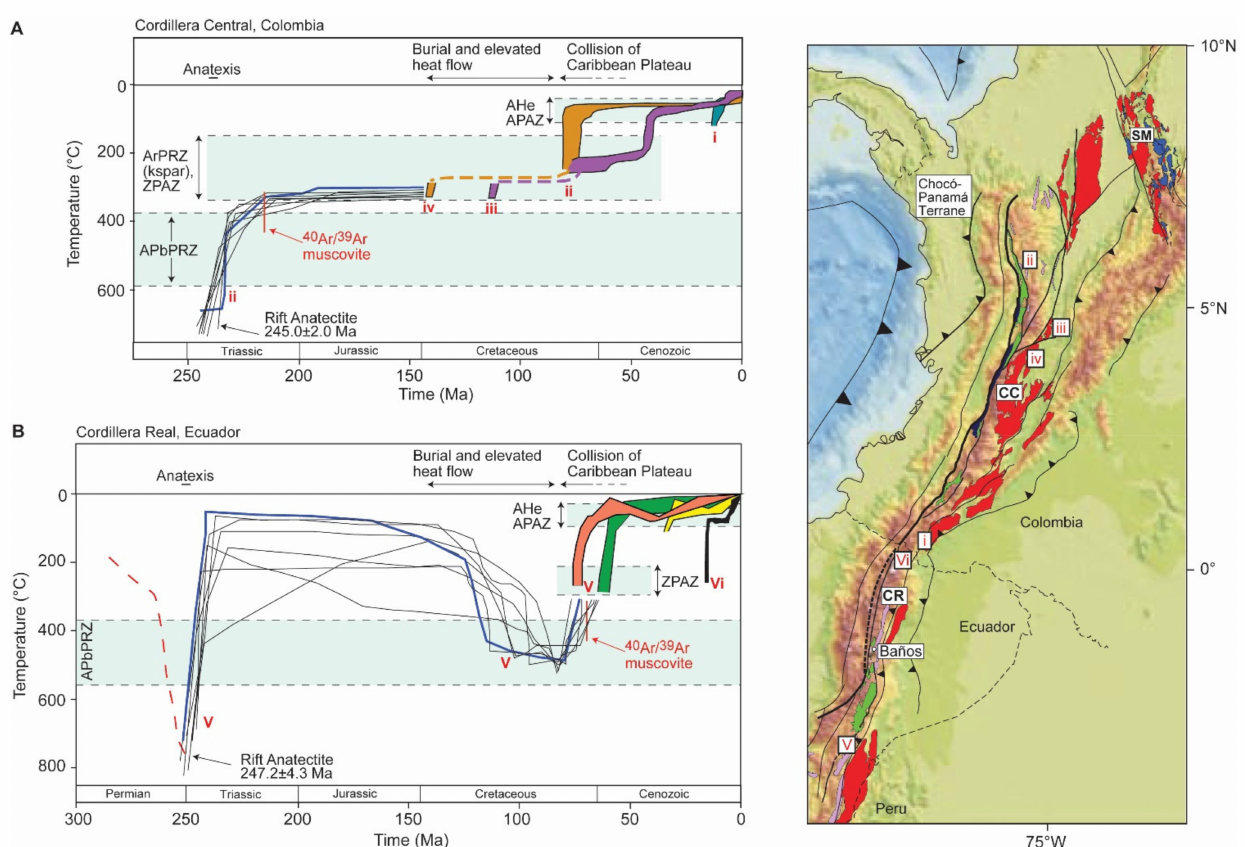
Figure 7. Thermochronological data obtained from Triassic and younger crystalline from ( A ) northern Colombia, and ( B ) southern Ecuador. Time-Temperature solutions have been obtained from (i) apatite U-Pb dates obtained for Triassic felsic crustal anatectites (black lines, blue line is the best-fit), (ii) 40 Ar/ 39 Ar muscovite (Ecuador and Colombia; vertical red bars) and alkali feldspar (Colombia only, proximal to the Ibagu é Fault; solid envelopes) data, and (iii) zircon and apatite fission track and (U-Th)/He data (Colombia and Ecuador; solid envelopes). Solutions are only shown for the cordilleras Real and Central. Plateau muscovite 40 Ar/ 39 Ar dates overlap with the t-T solutions obtained from the apatite U-Pb data. Modelling details and data are provided in Spikings et al. (2010) [85], Cochrane et al. (2014) [84], Paul et al. (2018) [23] and Spikings and Paul (2019) [24].